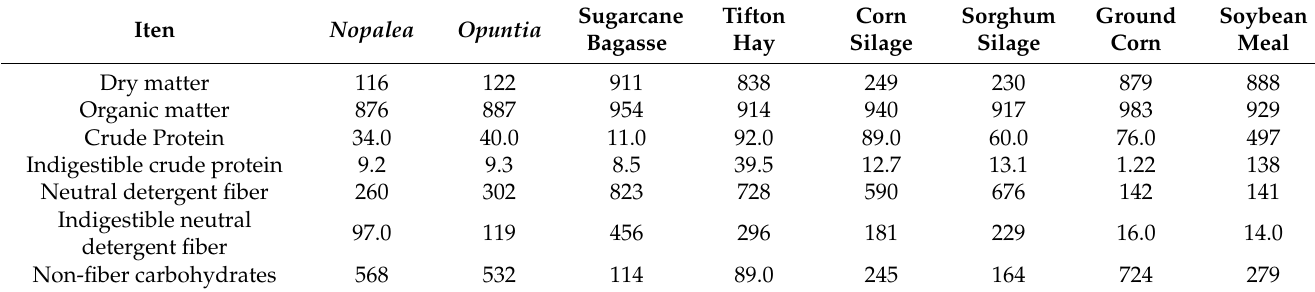
Table 1. Chemical composition of ingredients used in the experimental diets (g/kg DM).